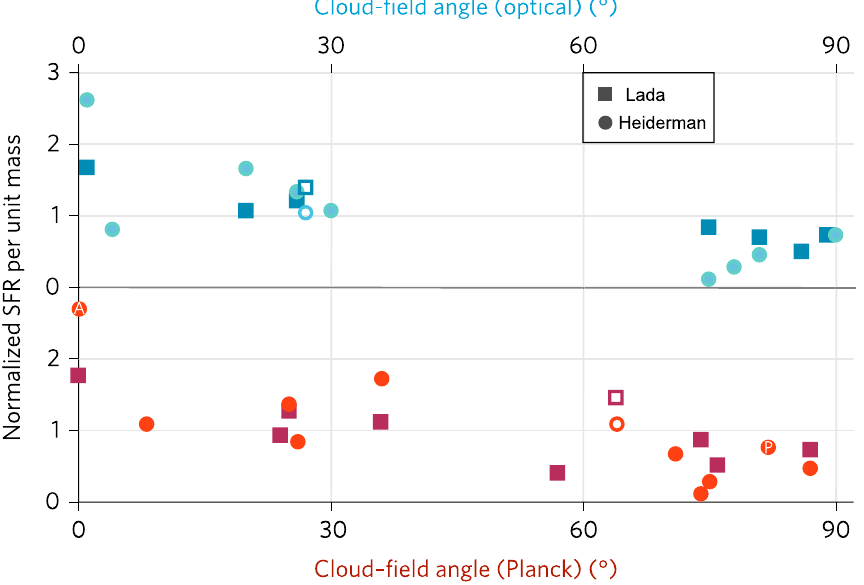
Figure 7. Star formation rate (SFR) per unit mass versus cloud-field directional offset for Gould Belt clouds [35]. The SFR are from Heiderman et al. [19] (circles) and Lada et al. [18] (squares). The “cloud-field angle” is the directional difference between the B-field and cloud elongation. The B-field directions are inferred from optical (blue) and sub-mm (red) polarimetry [35], while the cloud elongations are based on the autocorrelation of the extinction data [15]. All four possible combinations of SFR/mass vs. angle show anti-correlation. The SFR from [18] comes without uncertainties, so we [35] performed a permutation test and Spearman rank correlation test of a negative correlation. For the data from [19], which is with uncertainties, the same tests were performed with bootstrap samples from log-normal distributions with the uncertainties as the standard deviations. All test results (four data combinations × two tests) are significant (with very low P-values; see [35] for details).